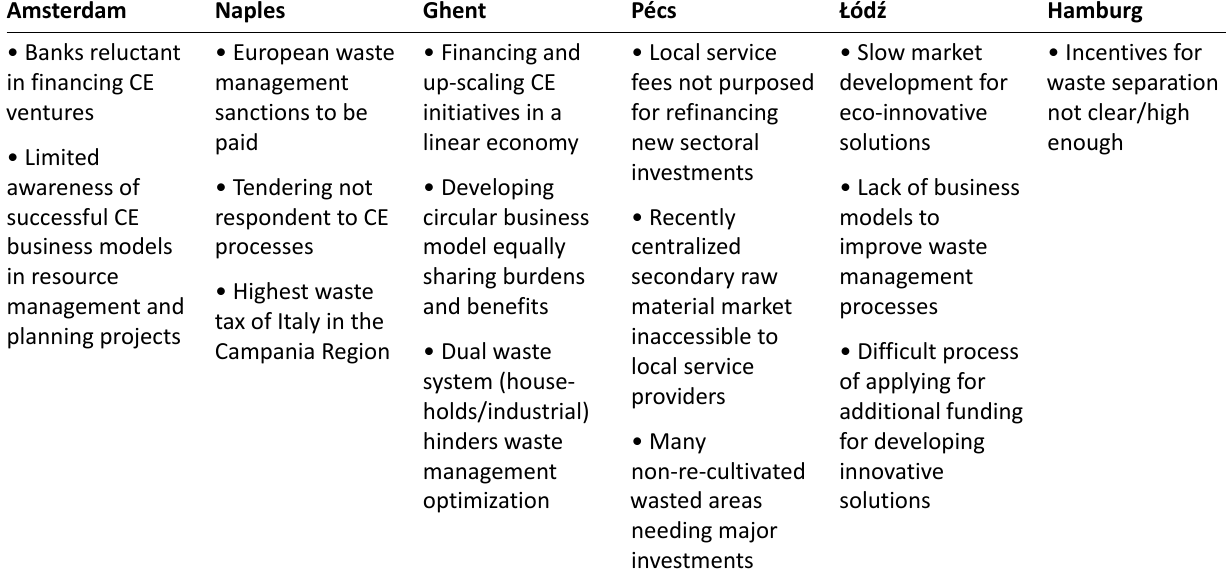
Table 3. Governance challenges: Economic/financial.